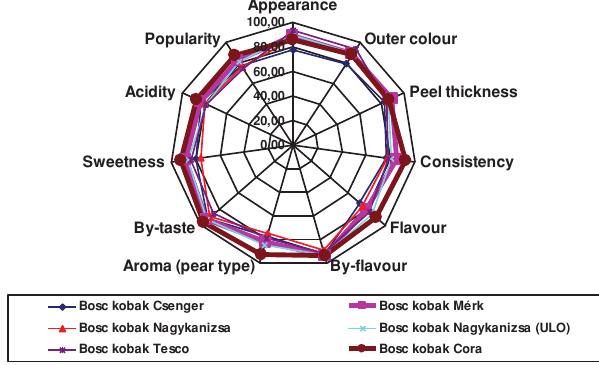
Figure 2. Bosk kobak